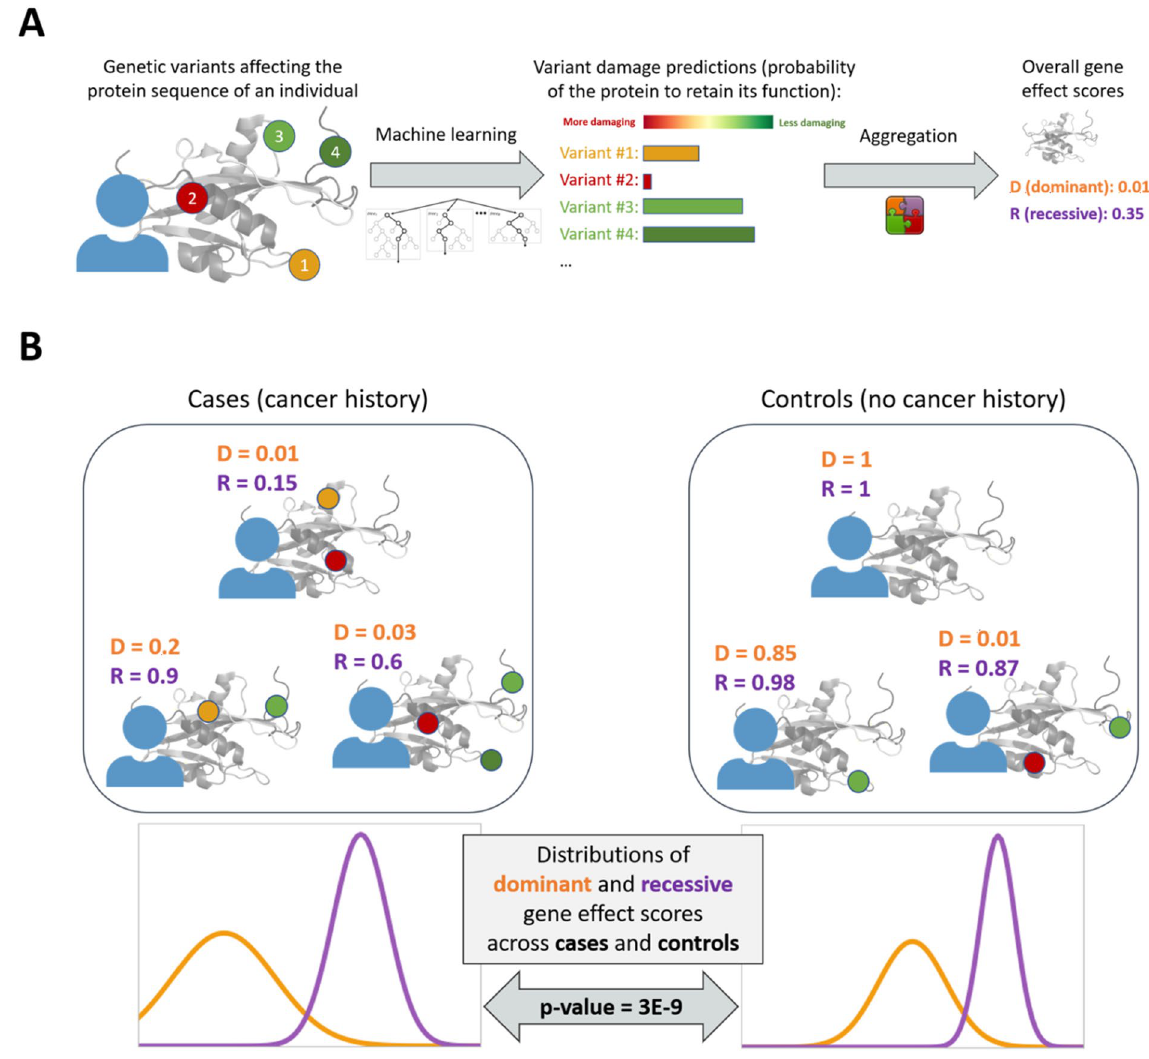
Figure 1. Proteome-wide association study (PWAS). PWAS finds associations between phenotypes (such as cancer) and protein-coding genes that are mediated by genetic alterations to protein function. ( A ) When studying a protein-coding gene, PWAS collects all the called variants in the genome of an individual that affect the coding sequence of that protein. Using a machine-learning model, it predicts how damaging these variants are to the protein function (for example, how likely an enzyme is to retain its catalytic activity given each of the mutations, which might affect its 3D structure). It then aggregates the predictions made for all the variants into overall gene effect scores. Each gene is assigned two such scores, corresponding to either a dominant or a recessive genetic effect. The dominant effect score attempts to capture the event that the gene is affected by at least one damaging variant, whereas the recessive effect score attempts to capture the event that it is affected by at least two damaging variants. ( B ) Given a cohort of cases and controls, PWAS assigns each individual dominant and recessive effect scores for the studied protein-coding gene based on his or her genetics, as described in ( A ). By comparing the distributions of gene effect scores assigned to cases and controls, PWAS can detect statistically significant differences between the two groups (measured by p -values and FDR q-values). These differences reflect the estimated functional damage to the gene, finding, for example, that the studied protein appears to be more damaged in cases than in